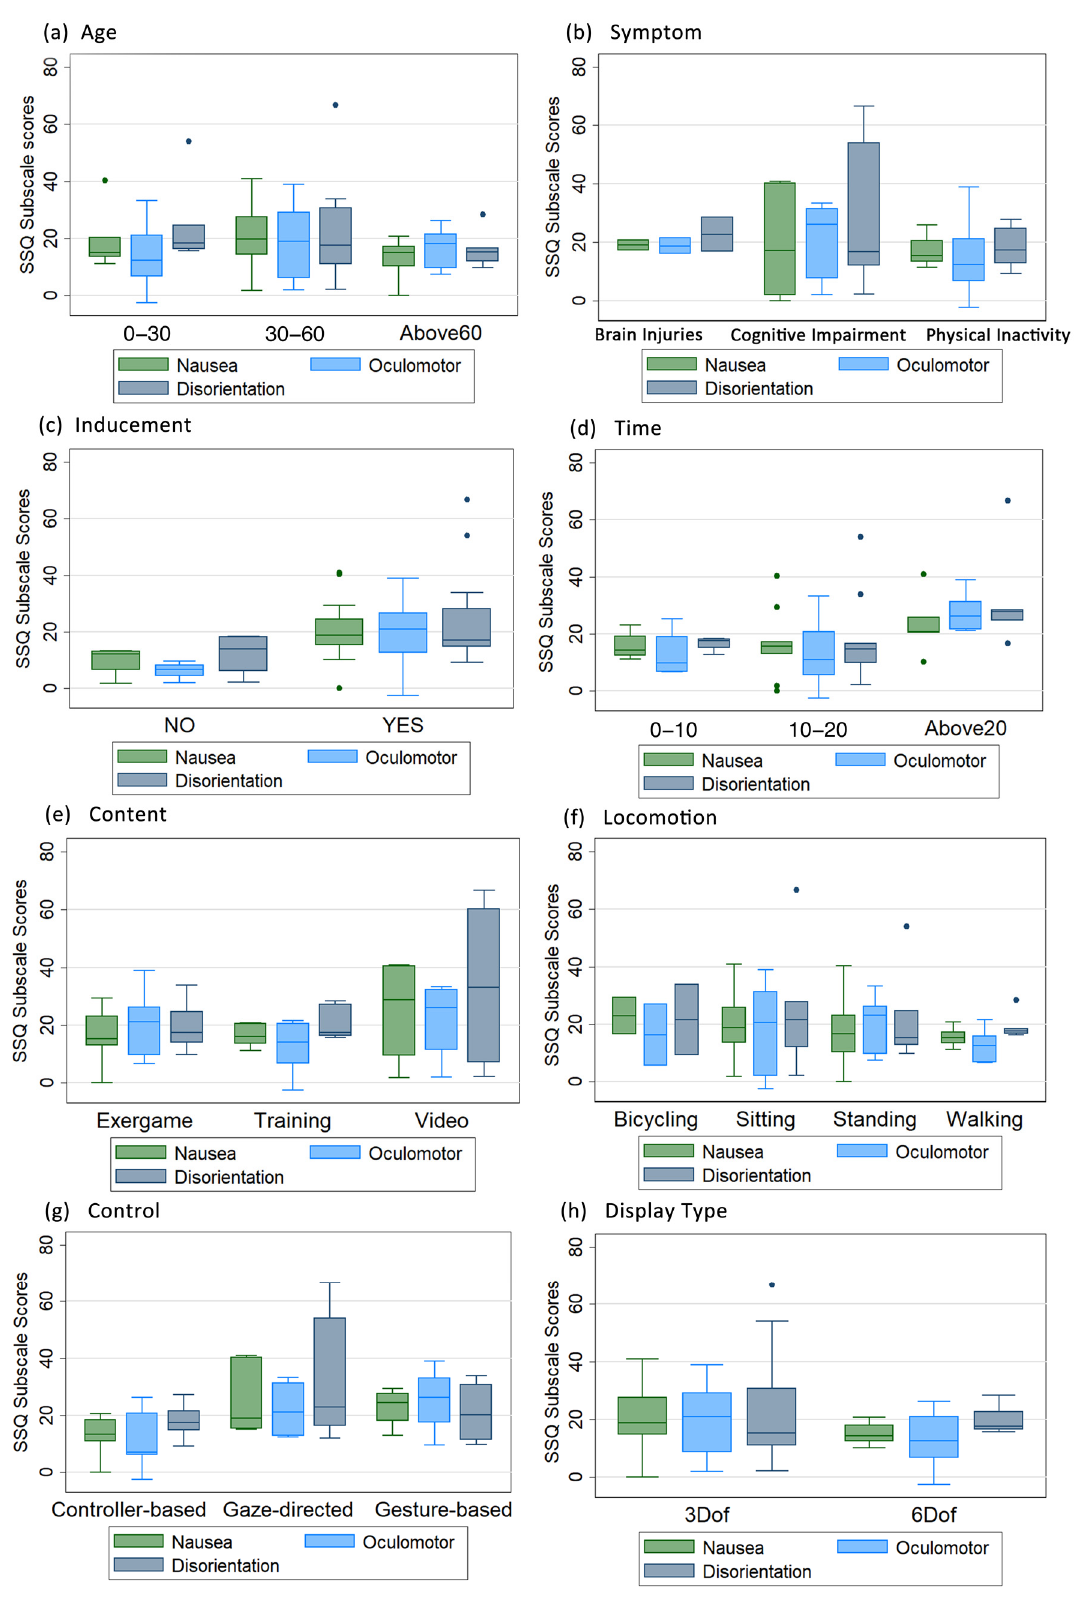
Figure 4. Boxplots for SSQ subscale scores: (a) Age, (b) Symptom, (c) Inducement, (d) Time, (e) Con- tent, (f) Locomotion, (g) Control, (h) Display Type.